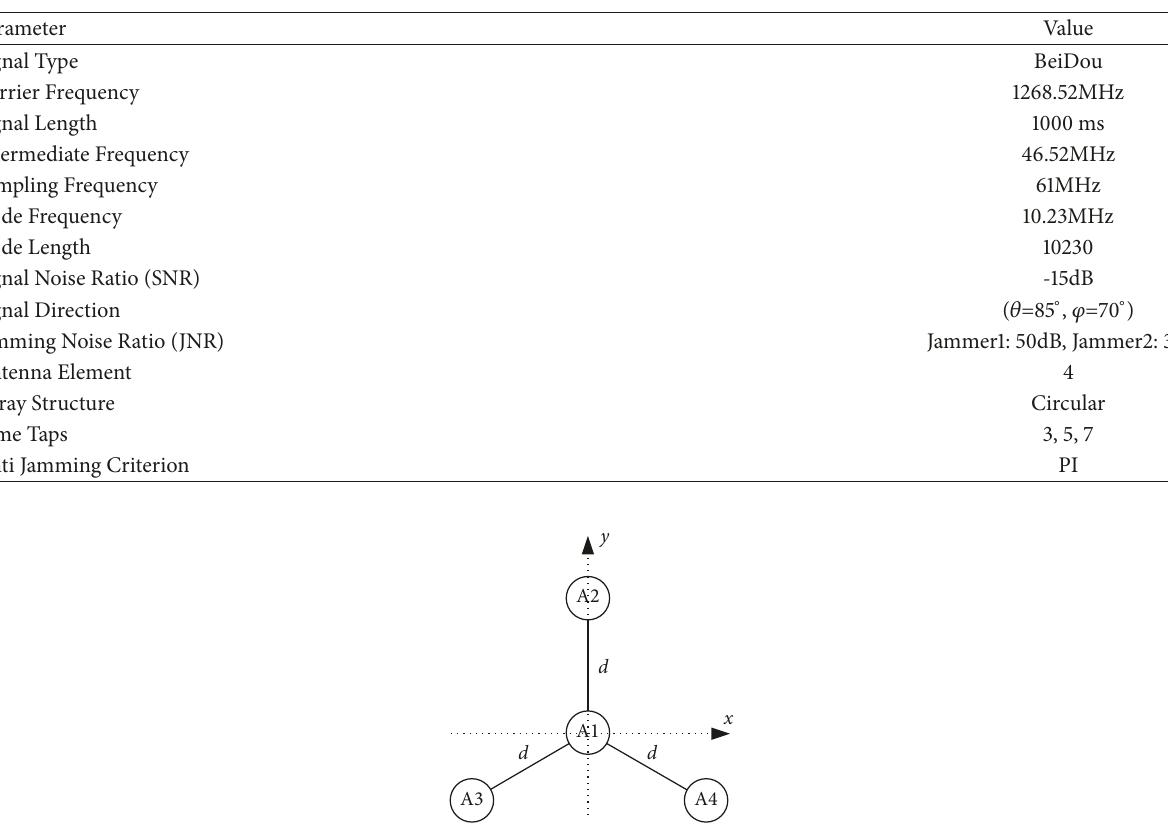
Table 1: Simulation parameters.